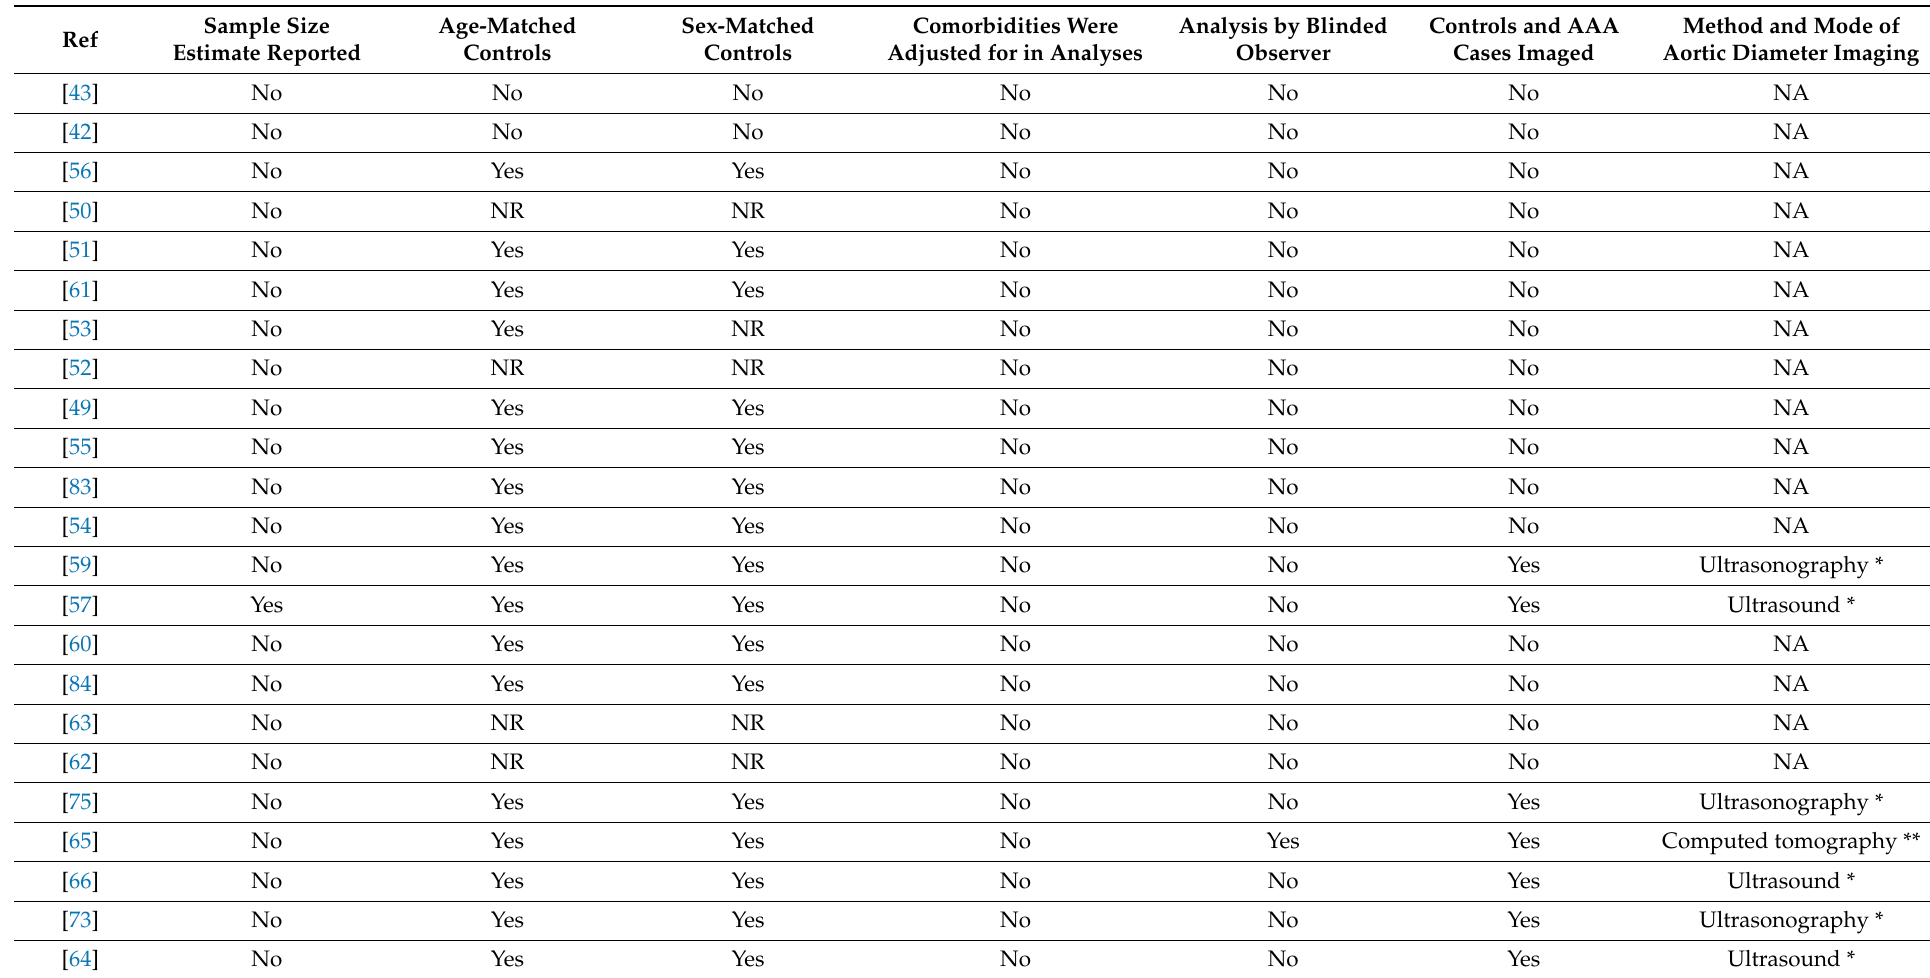
Table 5. Quality assessment of the clinical studies investigating tumor necrosis factor or interleukins. Sample Ref